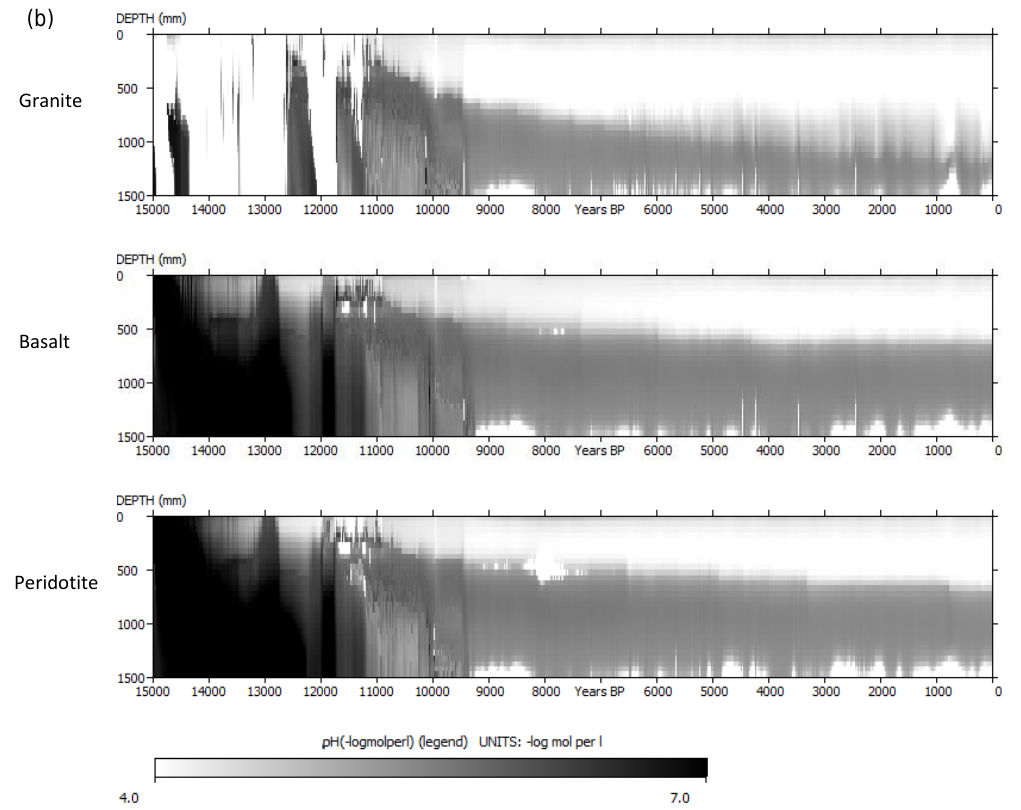
Figure 2. (b) Time-depth evolution of pH with interactive soil-forming processes (Model B) for three parent materials with texture number 5 (Table 1).